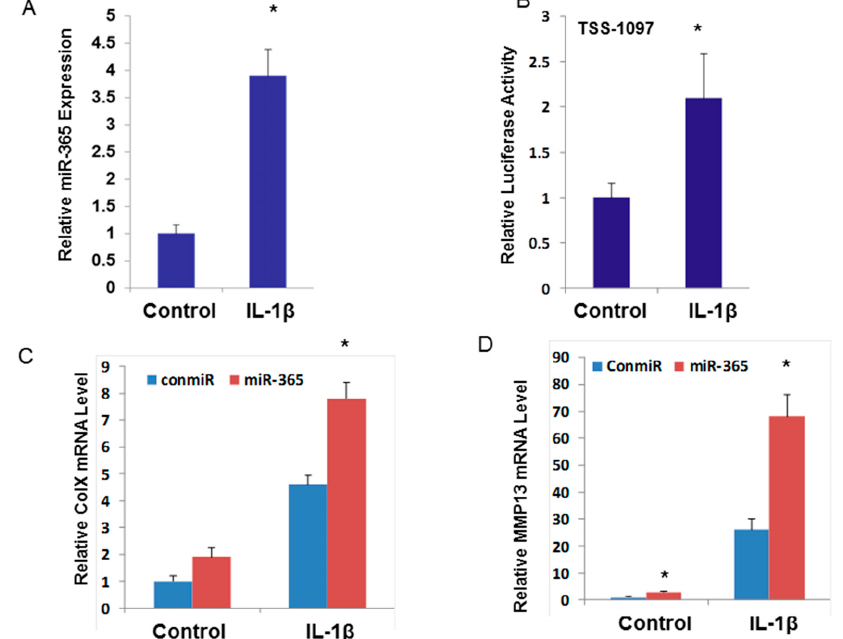
Figure 2. IL-1 β stimulates miR-365 and exacerbates the catabolic effect in human articular chondrocytes. ( A ) Articular chondrocytes isolated from human cartilage were treated with 10 ng/mL Il-1 β for 24 h. miR-365 expression was determined by real-time PCR. * p < 0.05; ( B ) Human articular chondrocytes were transfected with TSS-1097-Luc reporter and treated with 10 ng/mL Il-1 β 24 h post transfection. Luciferase activities were measured 24 h later; ( C , D ) Human articular chondrocytes were transfected with miR-365 mimic or control mimic and treated with or without Il-1 β at 24 h post-transfection. RNA was collected 24 h later and the expression level of collagen type X (Col X) and metallopeptidase 13 (MMP13) was analyzed by real-time PCR. Control mimic transfected without IL-1 treatment was regarded as 1. n = 3, * p <